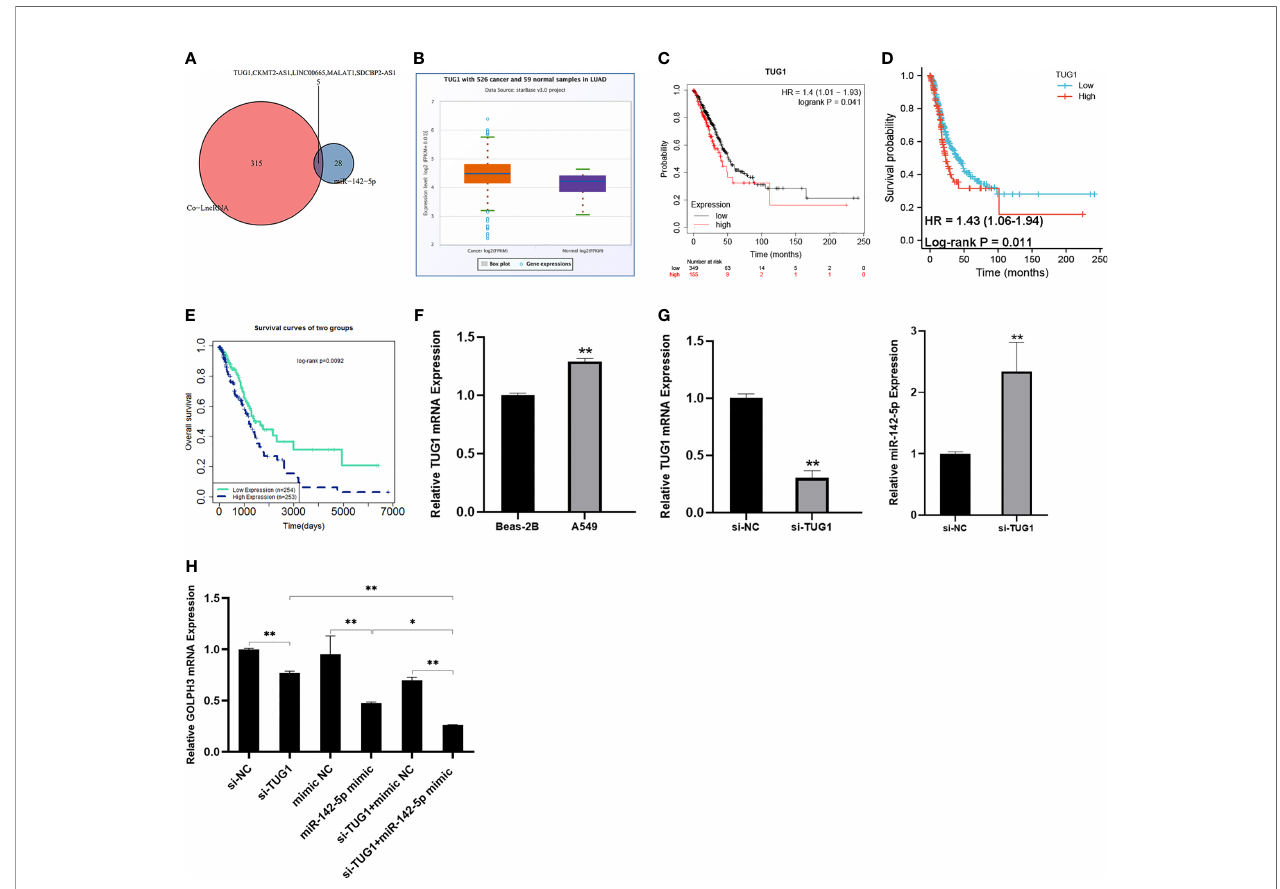
FIGURE 9 | Construction of lncRNA – miRNA – GOLPH3 network. (A) Candidate lncRNAs are predicted by co-LncRNA and starBase. (B) The expression of TUG1 in LUAD by starBase. (C) The overall survival (OS) of TUG1 in LUAD by Kaplan – Meier plotter. (D) The fi rst progression (FP) of TUG1 in LUAD using TCGA database. (E) The overall survival (OS) of TUG1-miR-142-5p-GOLPH3 in LUAD by LnCeVar. (F) The expression of TUG1 in Beas-2B and A549 cells using qRT-PCR. (G) The expression of TUG1 and miR-142-5p in A549 cells with knockdown of TUG1 using qRT-PCR. (H) The expression of GOLPH3 in A549 cells with siTUG1 and miR-142-5p mimic using qRT-PCR. * p < 0.05, ** p < 0.01. LUAD, lung adenocarcinoma; TCGA, The Cancer Genome Atlas.